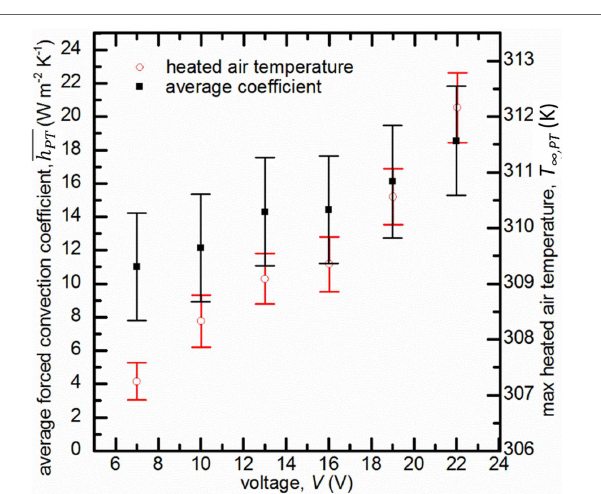
FIGURE 10 | The average convection coefficient across the surface of the plate and the max heated air temperature when the PT is placed 1cm away from the plate .